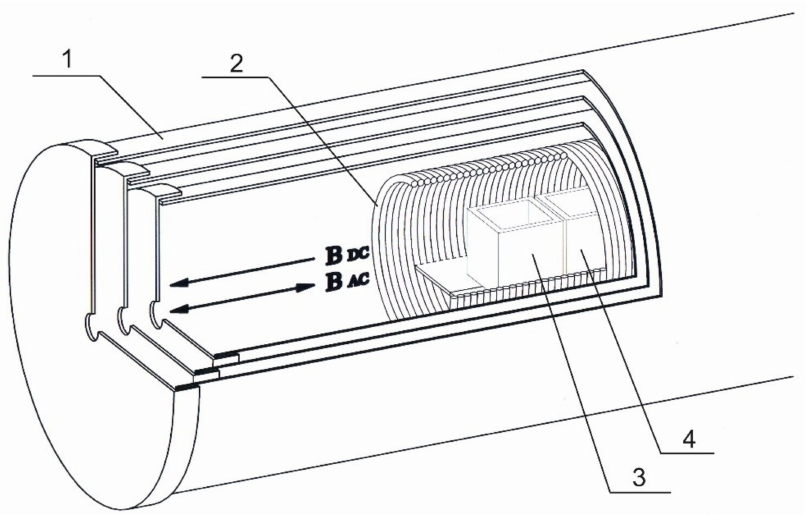
Figure 1. Controlled magnetic field generation device. 1—Permalloy shields; 2—Solenoid (magnetic copper wire coil); 3—Cuvette with an acceptor sample (sample of IFN γ or water); 4—Cuvette with a donor sample (HD Abs to IFN γ or HD PMA); B AC —Magnetic induction produced by alternating current; B DC —Magnetic induction produced by direct